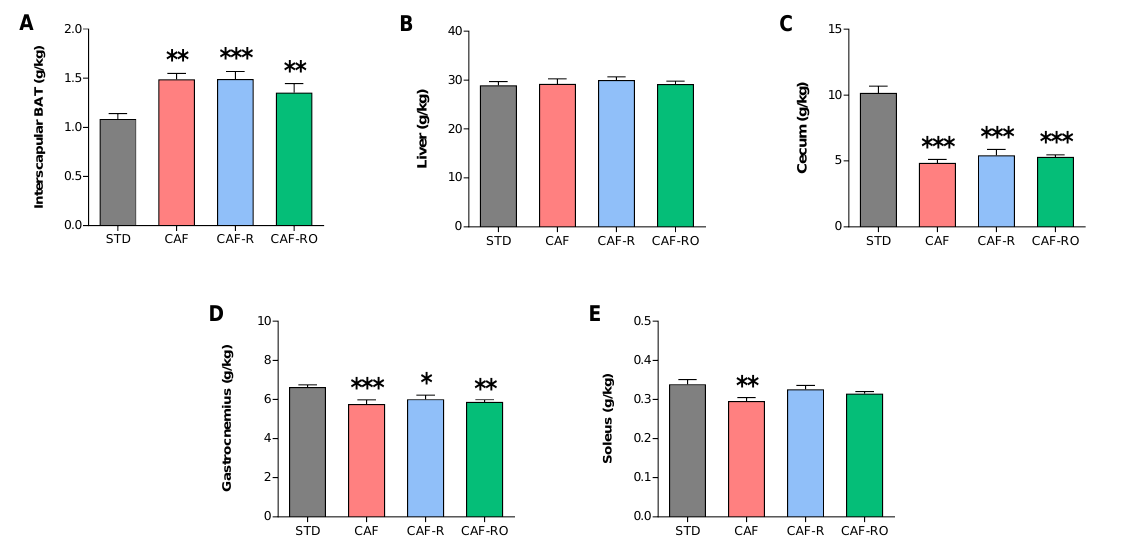
Figure 2. Effects of the dietary treatments on the relative weight of iBAT ( A ), liver ( B ), cecum ( C ) and gastrocnemius ( D ) and soleus ( E ) skeletal muscles. Tissue weights in grams were relativized to total body weight in kg. Data are expressed as the mean ± SEM. * p < 0.05, ** p < 0.01, *** p < 0.001 vs. STD group.